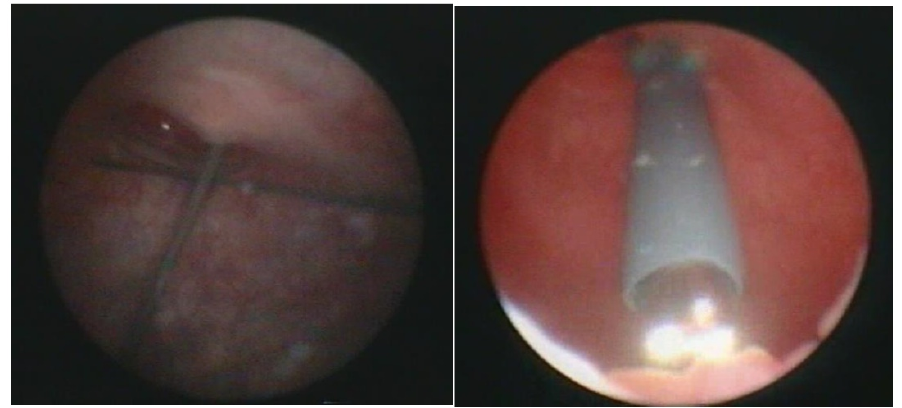
Figure 3. Transurethral cystoscopy controlling the percutaneous suprapubic bladder access.